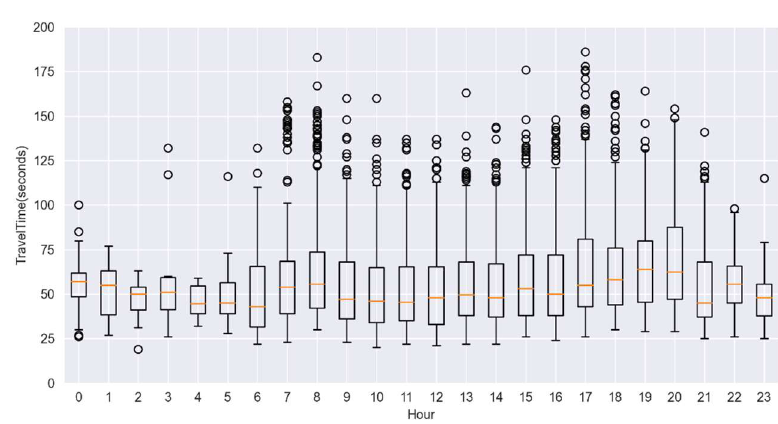
Figure 3. Box plot of travel time distribution in each hour within a day (for road link 1).